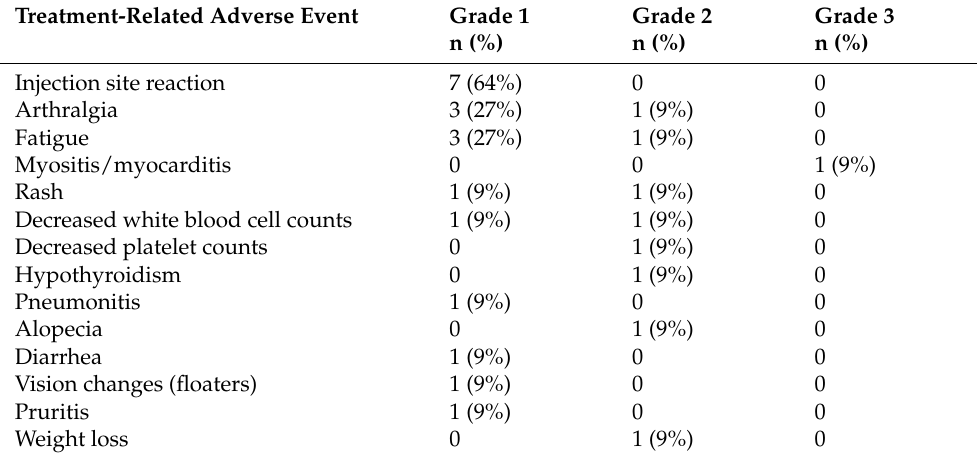
Table 2. Patients per maximum toxicity for treatment-related events (N =